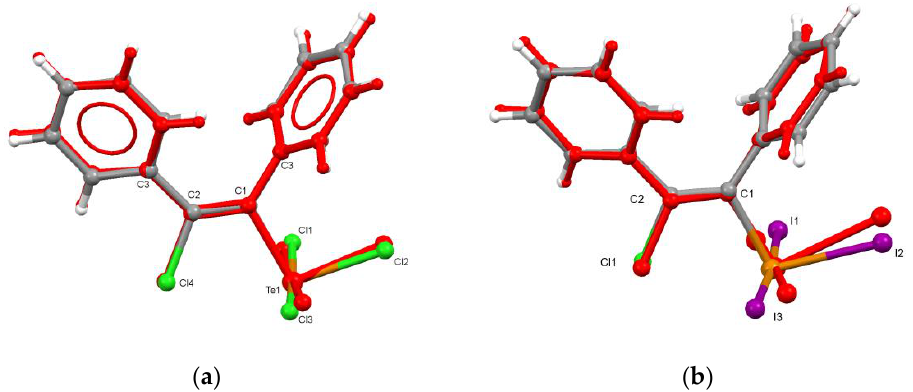
Figure 4. Molecular structure overlay of ( a ) (Cl)PhC=CPh(TeCl 3 ) molecules in 1α (red) and 1β ; ( b ) (Cl)PhC=CPh(TeI 3 ) molecules in 2α (red) and 2β .